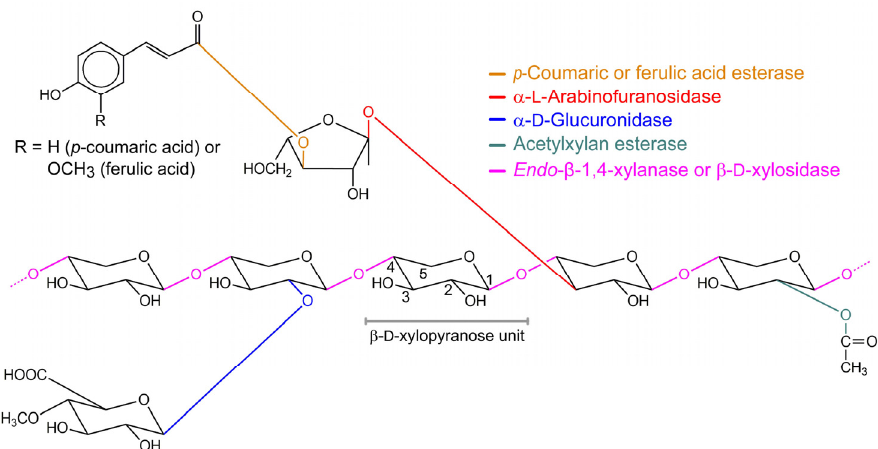
Figure 1. Example of the structure of a plant xylan with the cleavage sites of various xylanolytic enzymes indicated. A β - d -xylopyranose unit with numbered carbon atoms is shown in the middle. Glycosidic bonds and xylanolytic enzymes that hydrolyze them are depicted in the same color [7,9]. As a complex heteropolysaccharide, full degradation of xylan into its monosaccharide constituents requires the concerted action of various hydrolytic xylan-degrading enzymes with di ff erent specificities (Figure 1). These enzymes include α - l -arabinofuranosidase (EC 3.2.1.55), α - d -glucuronidase